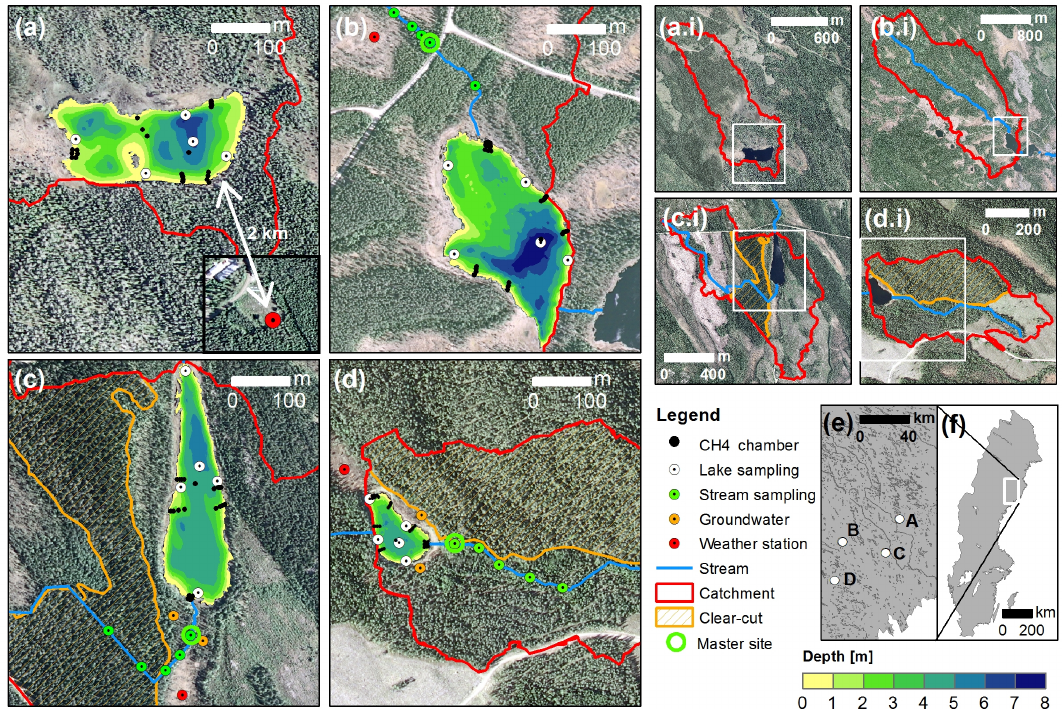
Figure 2. Maps of the experimental lakes and streams (a–d) , their catchments (a.i–d.i) and their location in Sweden (e–f) . Detailed maps show the lake bathymetry; the main channel of the inlet stream; the location of gas concentration sampling sites in lakes, streams, and hillslope groundwater; floating CH 4 chambers; and weather stations. Additional physicochemical sampling was done at the master stream site. White frames and dots in smaller-scale maps illustrate the extent or location of corresponding larger-scale maps, respectively. Panel labeling is consistent across all map scales and is as follows: (a) Stortjärn, (b) Övre Björntjärn, (c) Struptjärn, and (d)